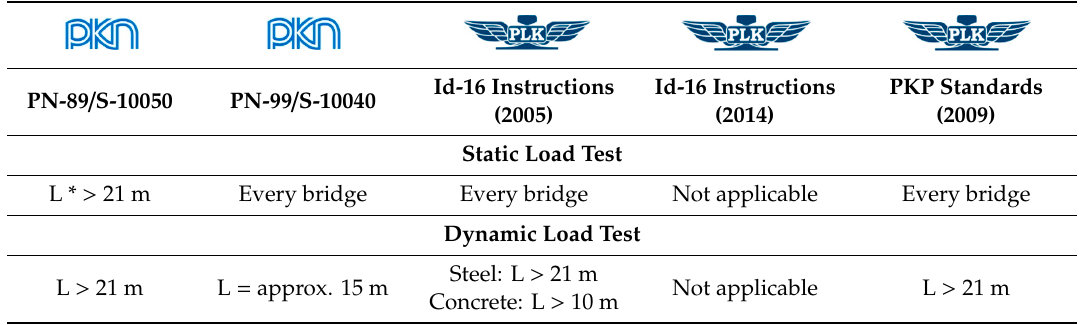
Table 1. Conflicts between PKN (the Polish Committee for Standardization) standards and PKP PLK